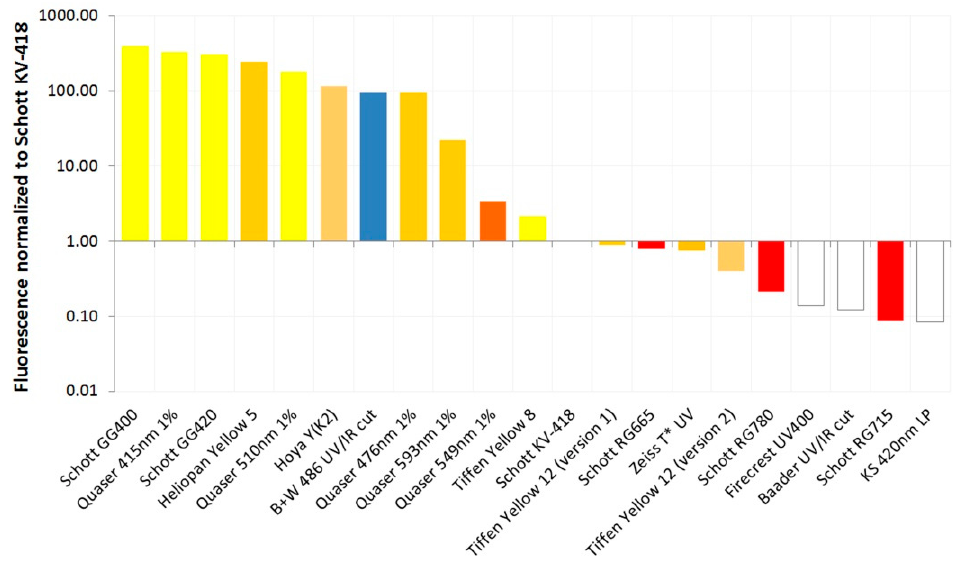
Figure 2. Fluorescence of the test photographic filters normalized to Schott KV-418. Bar color indicates the color of the filter fluorescence.